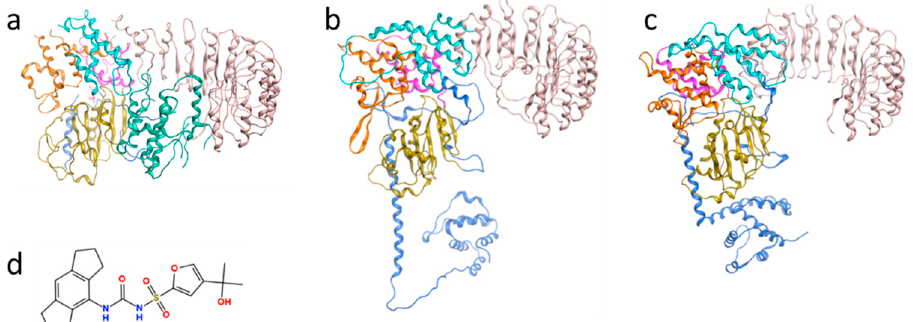
Figure 1. ( a ) Previously reported cryo-EM structures of NLRP3 complexed with NEK7 kinase (PDB code: 6NPY); the structures of NLRP3 predicted by ( b ) AlphaFold and ( c ) RoseTTAFold. Gold: NBD; Purple: HD1; Green: NEK7; Orange: WHD; Cyan: HD2; Pink: LRR; Blue: others. ( d ) The 2D structure of MCC950, which was reported as a selective NLRP3 inhibitor.